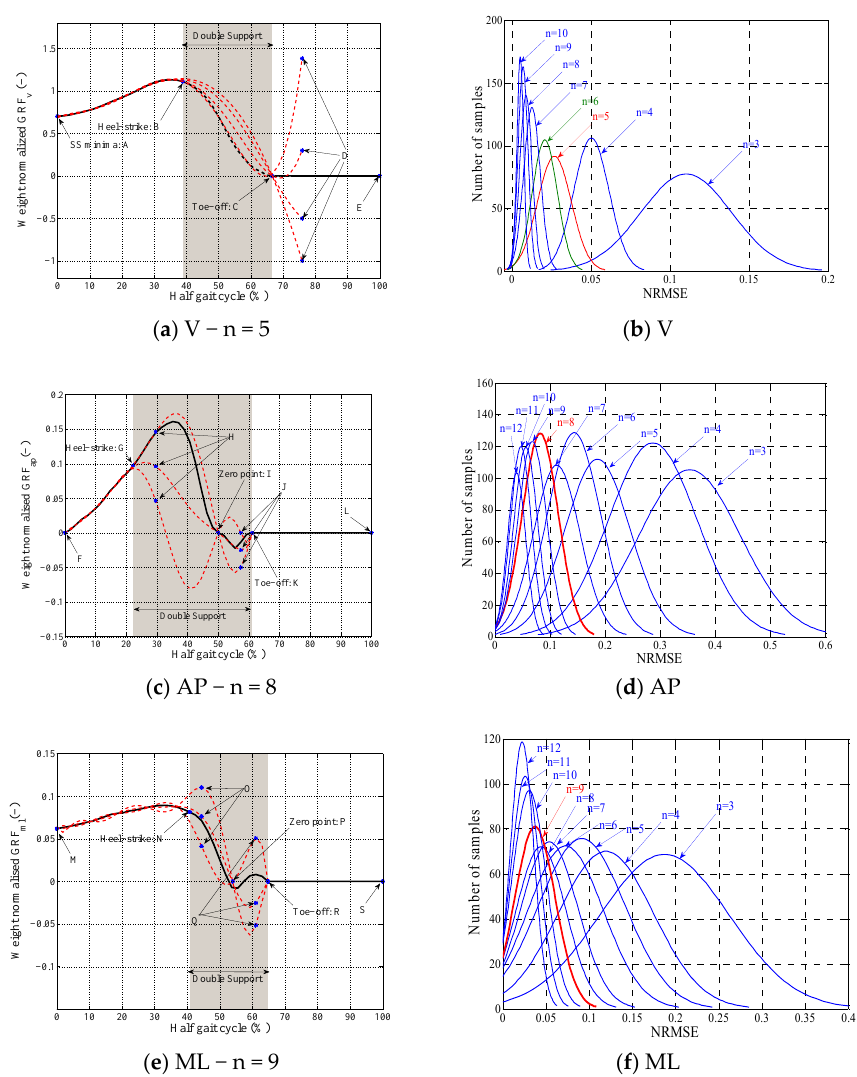
Figure 3. Using polynomials of degree n to fit hGRF v ( t )